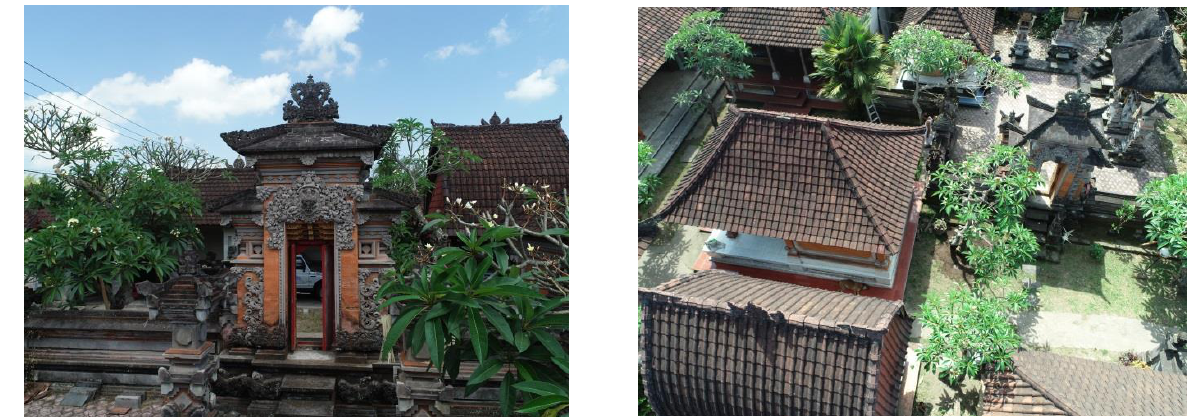
Figure 6. (left) Traditional gate of Balinese house. (right) Buildings architectures in Balinese house.